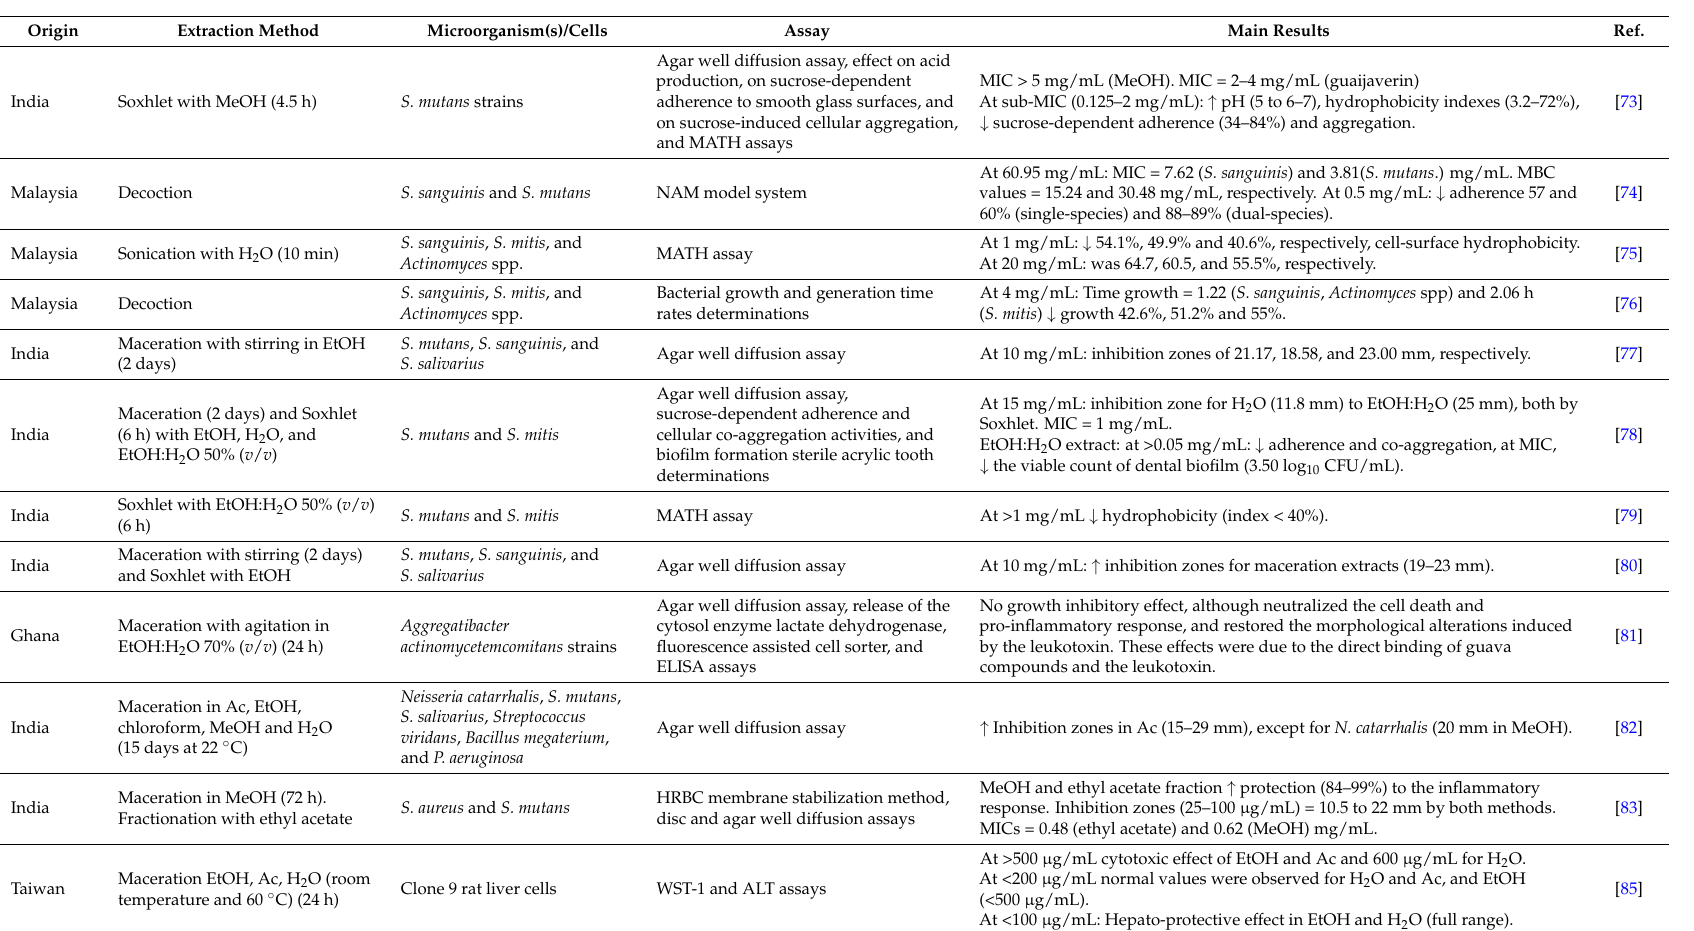
Table 5. In vitro assays against diseases related to the digestive